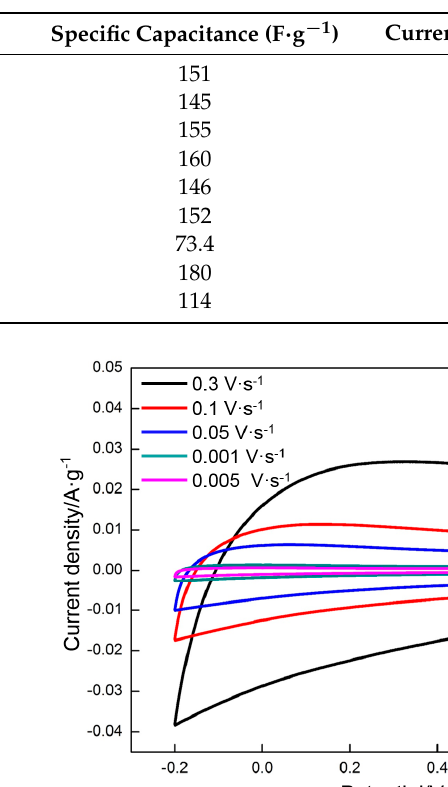
Table 1. Comparison of specific capacitance between this work and reported references.